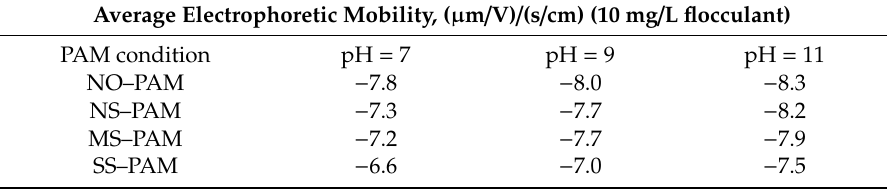
Figure 8. Electrophoretic mobility distributions of particles of molybdenite in the presence of NS–PAM, MS–PAM, and SS–PAM and at di ff erent values of pH. Table 2. Electrophoretic mobility and